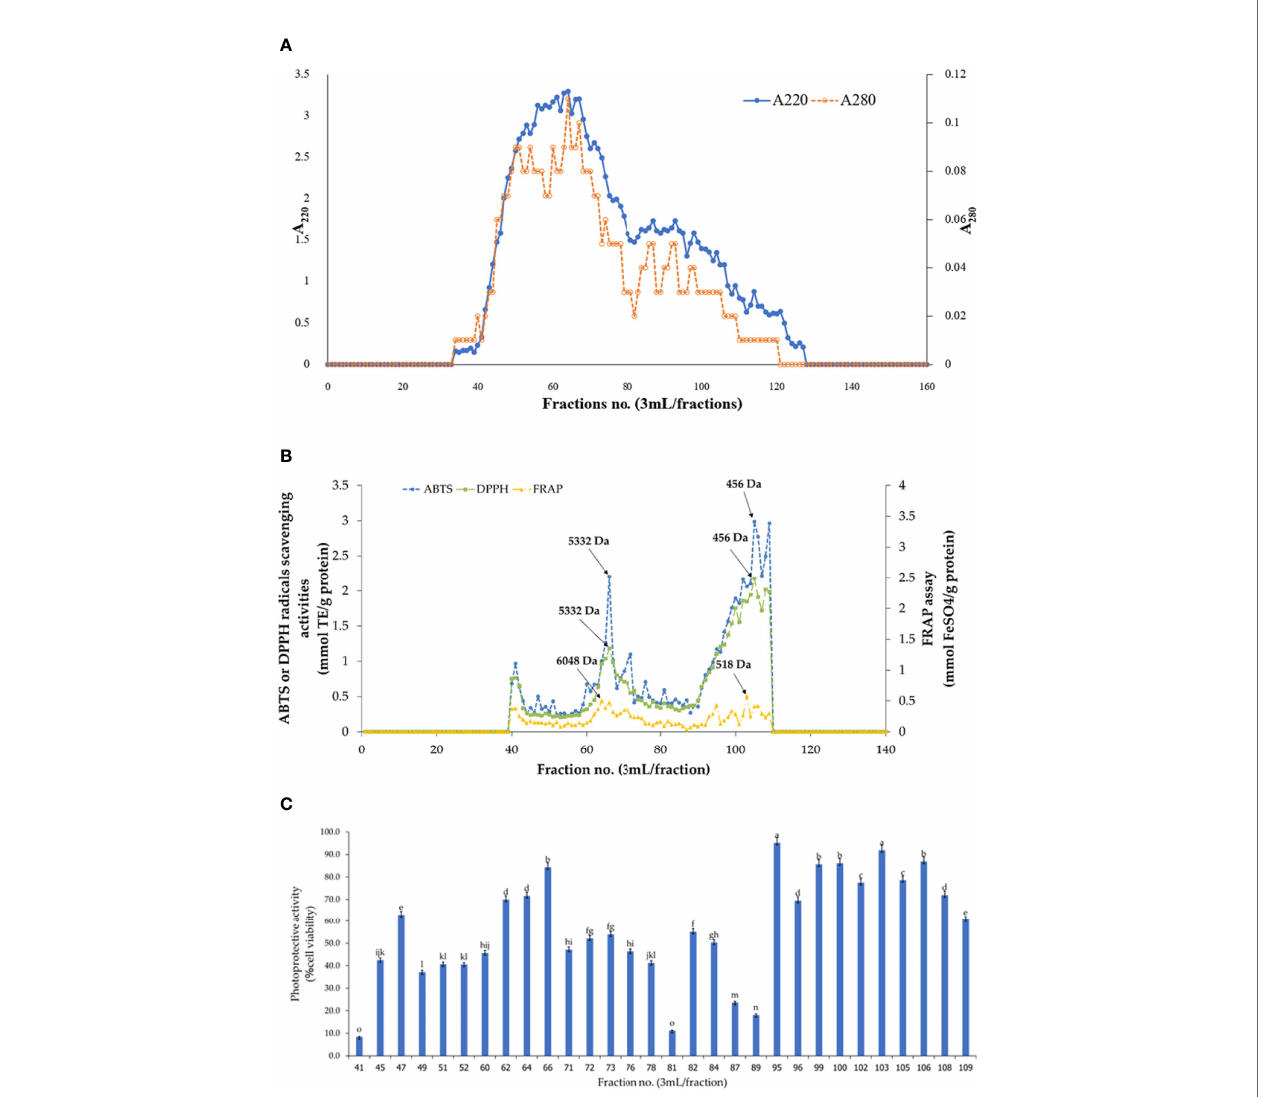
FIGURE 4 | Elution plot (A) absorbance at 220 and 280, (B) antioxidant activities, and (C) UV-B protective activity as %cell viability. Different small letters in bar graph (C) indicate signi fi cant differences (P ≤